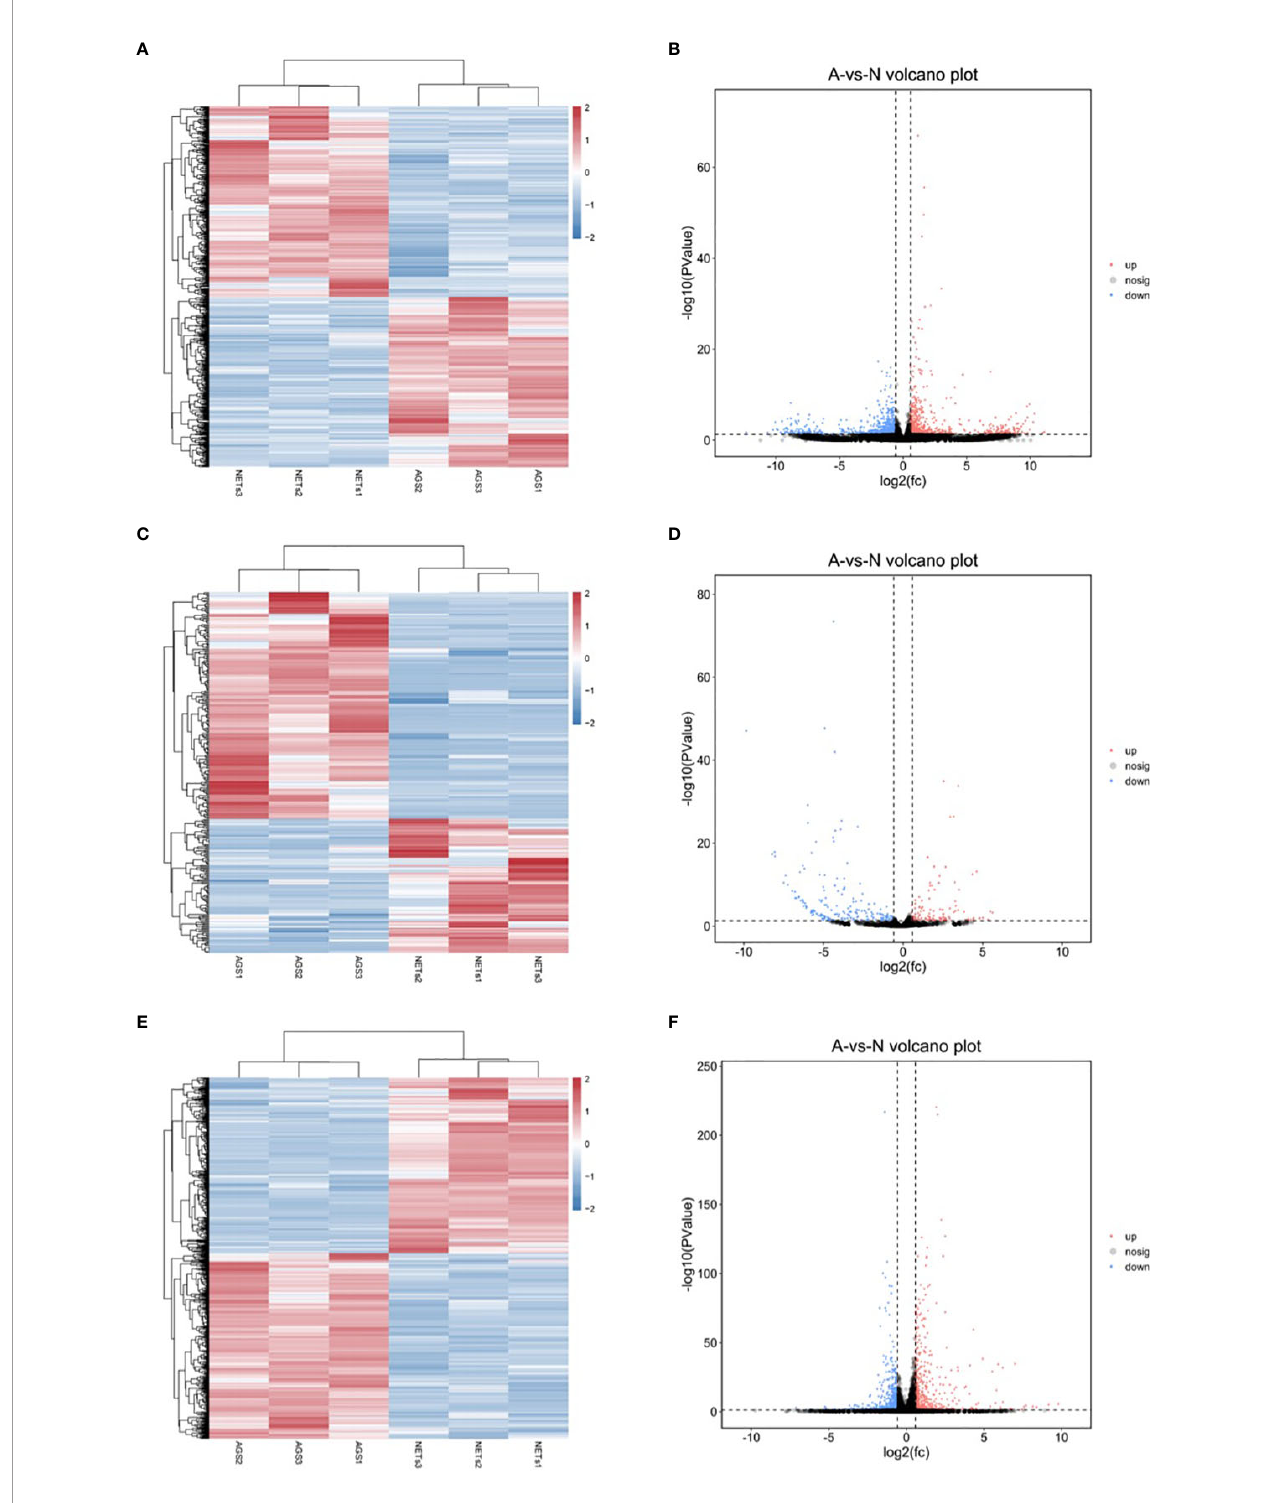
FIGURE 2 | The differentially expressed genes in gastric cancer cells treated by NETs. (A) Heatmap of differentially expressed lncRNAs. (B) Volcano plots of differentially expressed lncRNAs. (C) Heatmap of differentially expressed miRNAs. (D) Volcano plots of differentially expressed miRNAs. (E) Heatmap of differentially expressed mRNAs. (F) Volcano plots of differentially expressed mRNAs. p < 0.05, |log2(fold change)| >